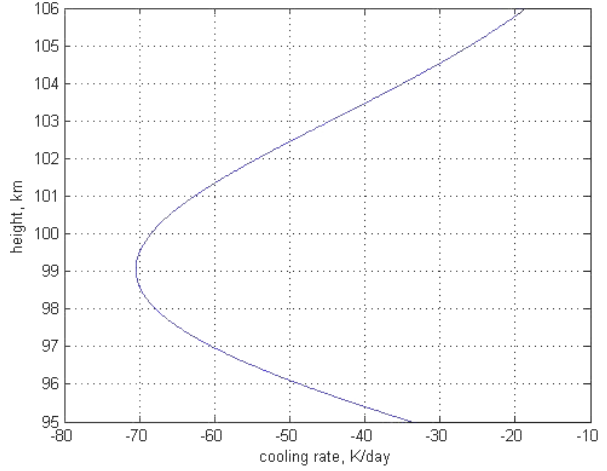
Fig. 6a. Height profile of the cooling rate in winter solstice calcu- lated with the coefficient of eddy heat transport equaled to the eddy diffusion coefficient shown in Fig. 2.